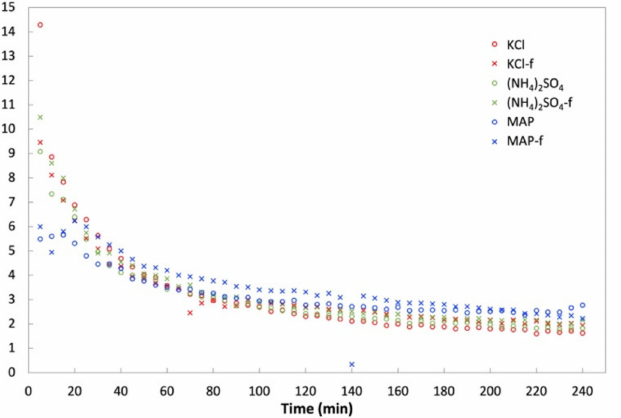
Figure 10. Water flux, J W , profile obtained during a 4-h operation with An-POME as FS and 1 M of various DS fertilizers.